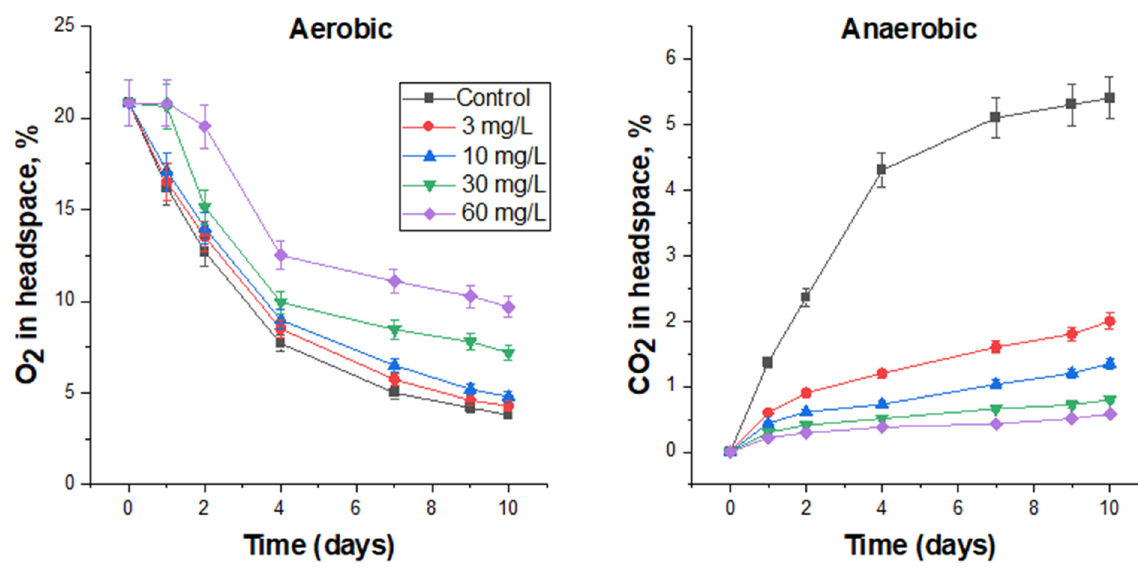
Figure 2. The effect of bronopol on O 2 consumption under aerobic conditions and CO 2 production under anaerobic conditions by the respective microbial communities in FS. By adding 30 mg/L of bronopol, it was possible to completely suppress microbial activity under aerobic conditions within one day (flat curve) and when its content was doubled, within two days. Then, the process of O 2 consumption in these vials began, but it was significantly lower than in the control. After 9 days, the slope of O 2 consumption in biocide-treated vials becomes flatter, which, apparently, as mentioned above, is associated with a decrease in the toxic effect of the biocide on the FS microbiota. Specific rates of oxygen consumption over 10 days in 30 and 60 mg/L treatments were 80.2 and 65.5% of the control, respectively (Table